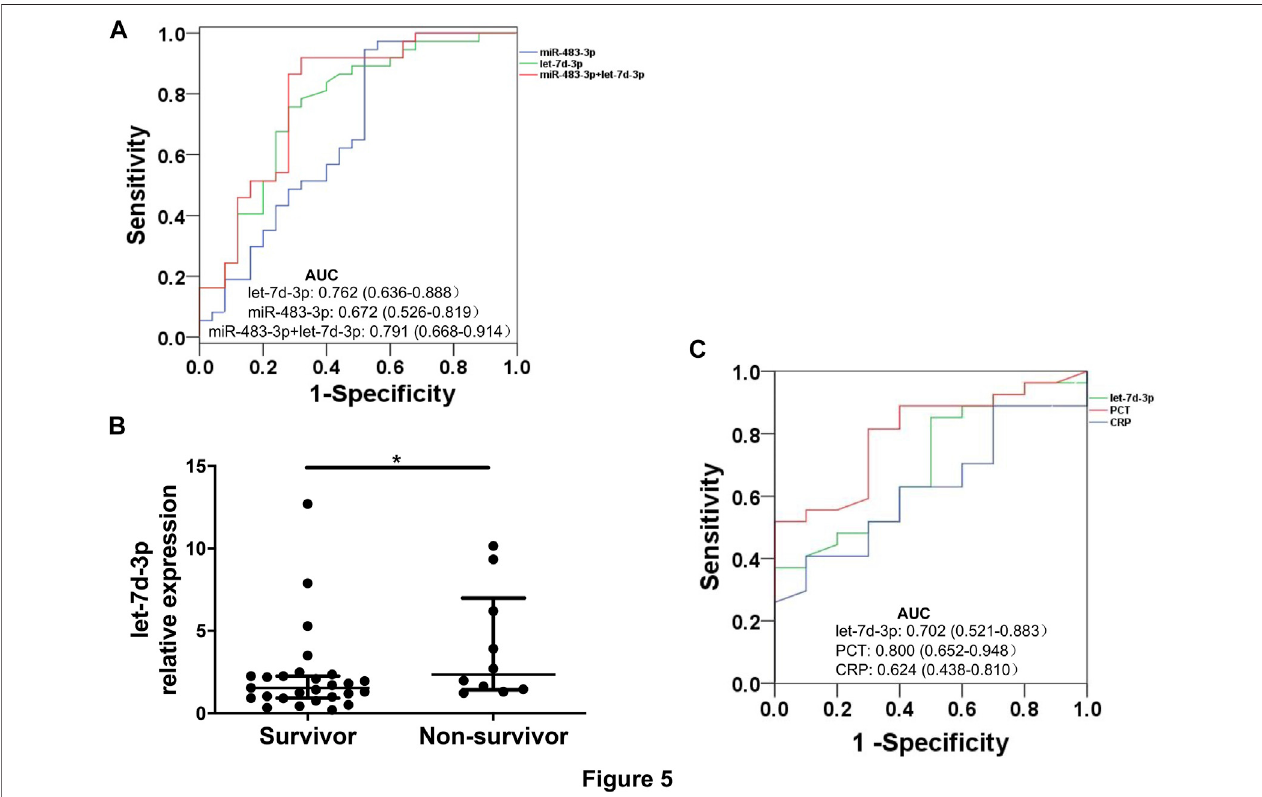
FIGURE 5 | ROC curves for sepsis diagnosis and mortality prediction. (A) ROC curves show sensitivity and speci fi city of plasma EV miR-483-3p and let-7d-3p, aloneorincombination,forsepsisdiagnosis. (B) LevelsofplasmaEVlet-7d-3pwerecomparedbetweennon-survivors( n =10)andsurvivors( n =27).Theplotshoweda median, interquartile range, and the individual data points. * p < 0.05. (C) ROC curves show sensitivity and speci fi city of plasma EV let-7d-3p, PCT, and CRP for predicting 28-day mortality.